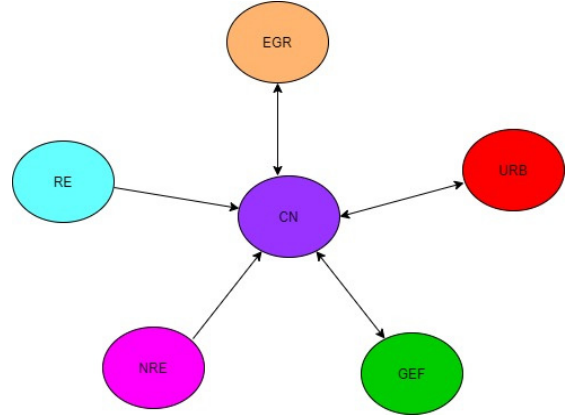
Figure 4. Causalities for HICs in MENA.